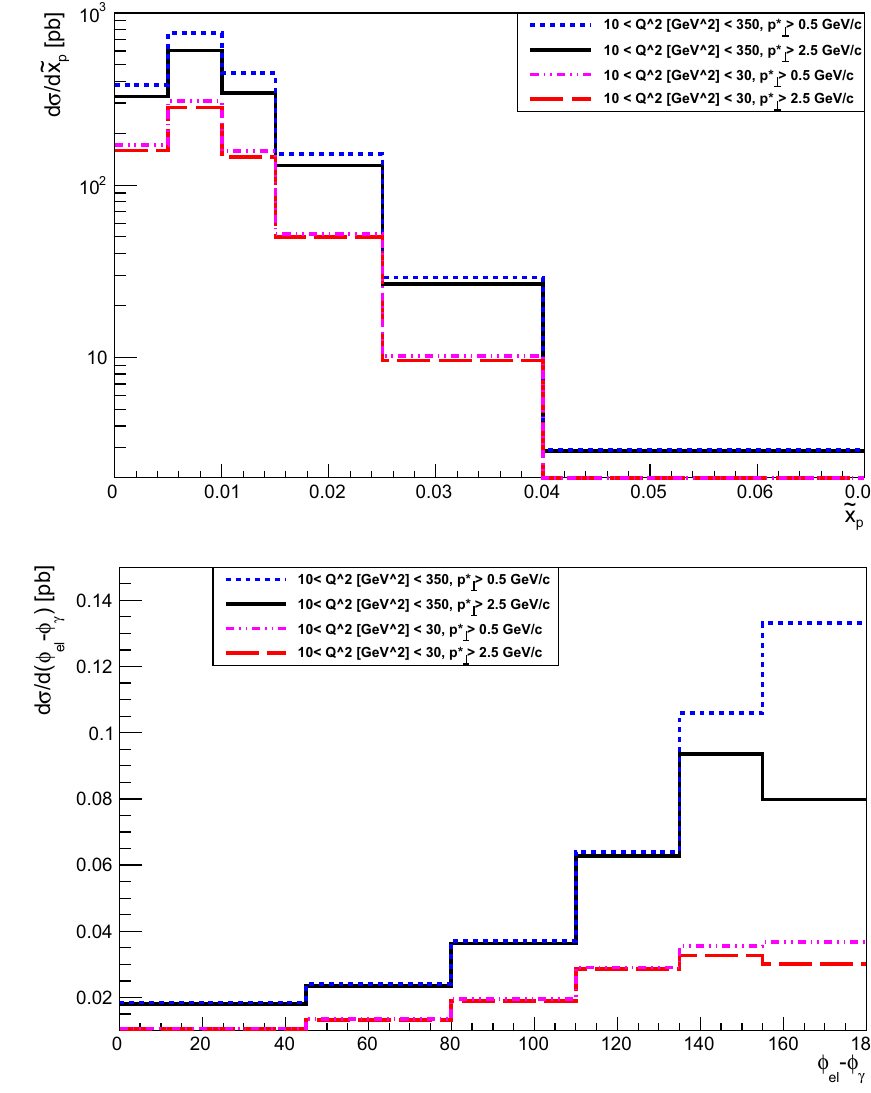
Fig. 3 d σ/ d ˜ x p cross sections for the ZEUS kinematics [7]